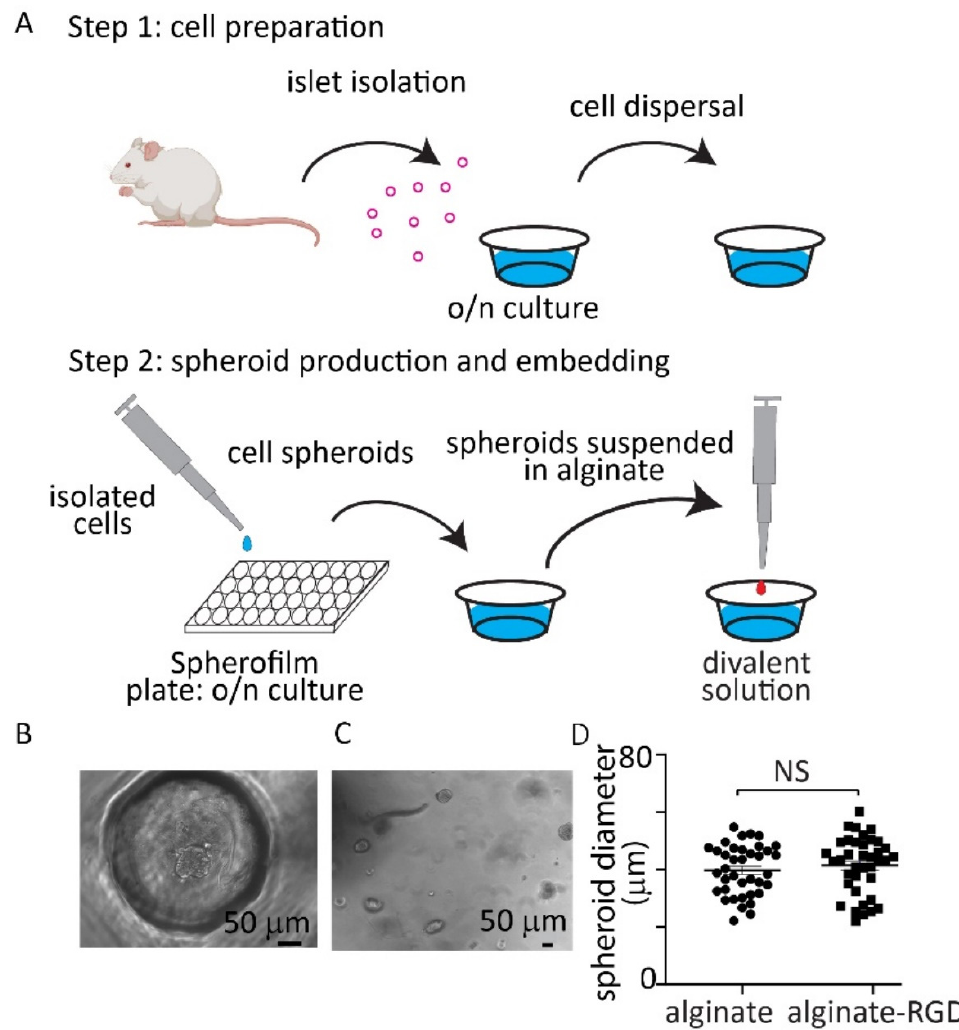
Figure 1. Preparation of spheroids of uniform size from native mouse β cells. ( A ) Cartoon represen- tation of protocol where pancreatic islets were harvested from mice, cultured overnight and then dispersed to single cells. These cells were then aggregated in low-adhesion wells to form spheroids of controllable size that were then embedded into alginate beads. ( B ) Example image of the formation of spheroids within the PDMS wells. ( C ) Example image of spheroids within alginate bead. ( D ) Analysis of spheroid diameter within alginate (0.5%) alone or alginate (0.5%) + RGD beads showed no significant differences (n = 38 clusters in both alginates, Student t test p = 0.43, cells from n = 3 mice).